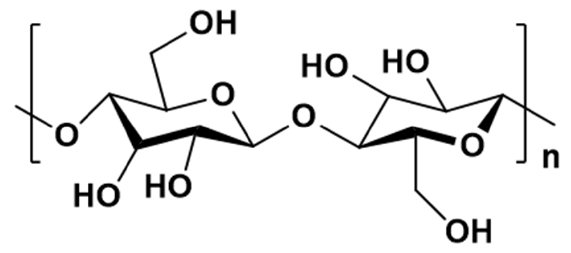
Figure 2. The molecular structure of cellulose.